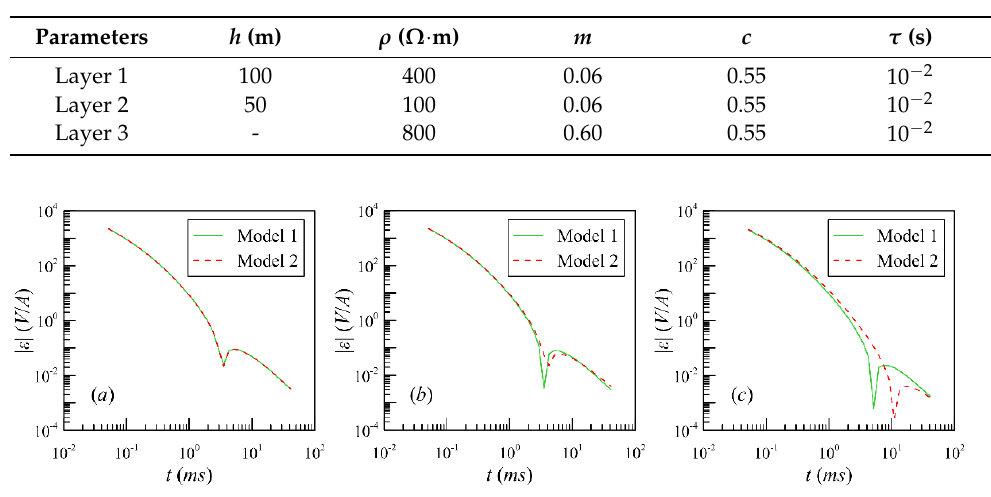
Table 2. Parameters of the three-layer model (Model 1).